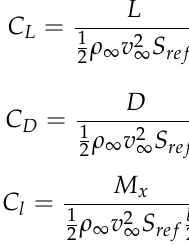
Figure 1. The coordinate system and sign convention for the research model.